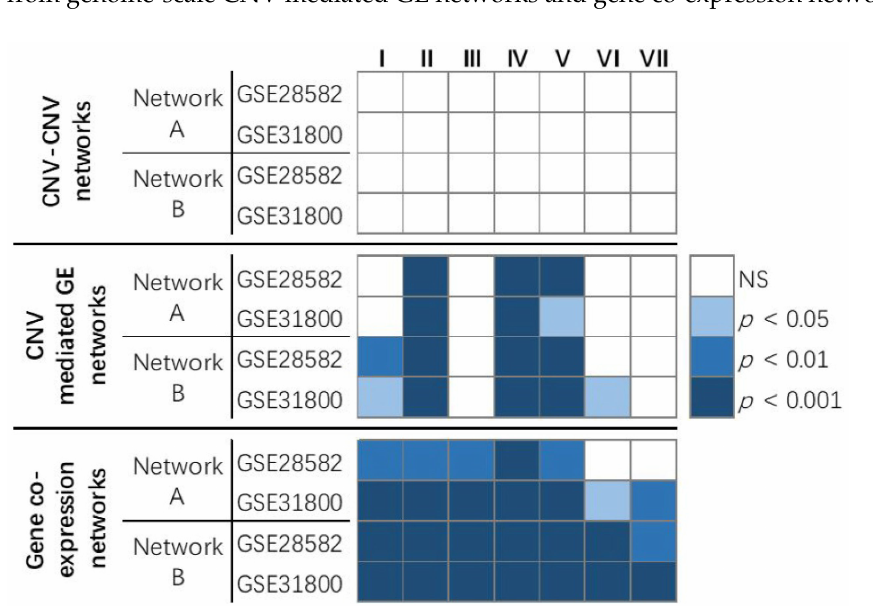
Figure 3. The comparison of centrality metrics of two published multi-omics networks vs. randomly selected networks with the same number of genes. Network A contains 30 genes in the CD27, PD1 , and PDL1 multi-omics network in NSCLC tumors [28]. Network B contains 66 genes in the multi- omics network of the 7-gene prognostic signature in NSCLC tumors [27]. The p values showed the percentage of randomly selected genes having a larger averaged centrality (except VoteRank) than networks A and B. The p value of VoteRank centrality showed the percentage of randomly selected genes having a lower averaged rank (one-tailed Wilcoxon rank sum test, p < 0.05) than networks A and B. Each column showed a centrality metric: I. degree centrality; II. in-degree centrality; III. out-degree centrality; IV. eigenvector centrality; V. closeness centrality; VI. betweenness